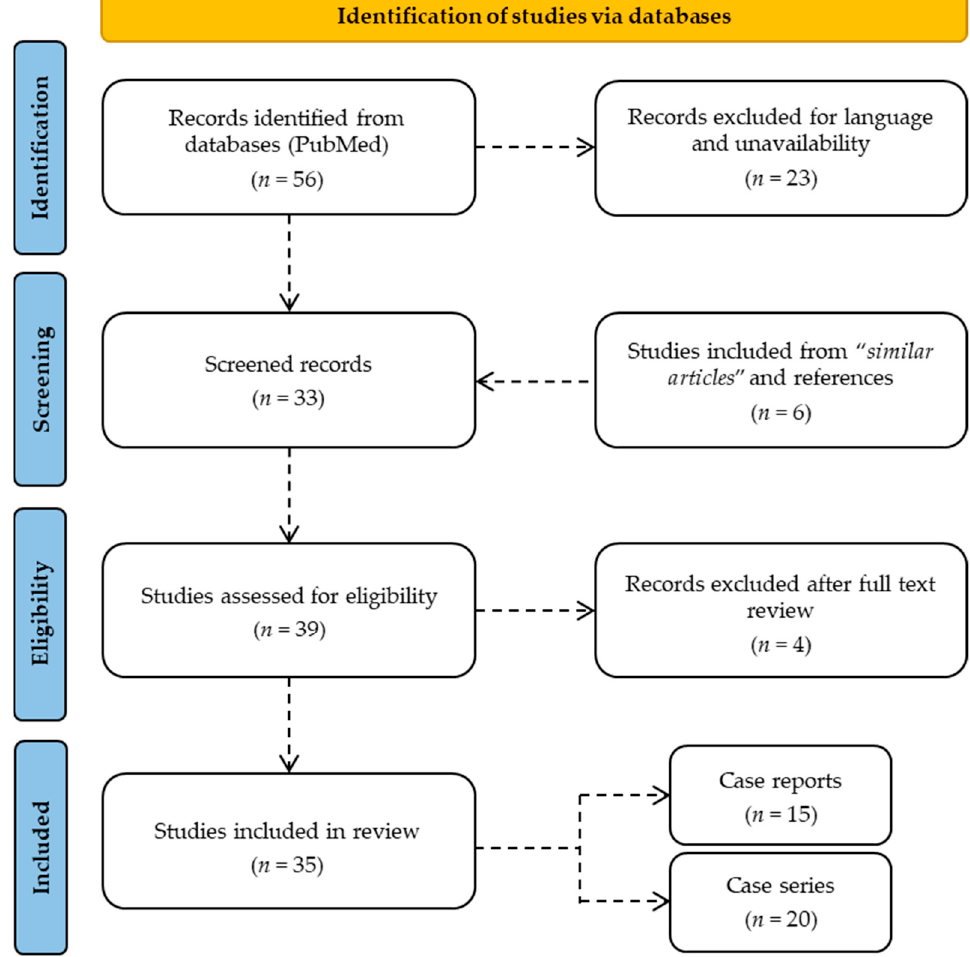
Figure 1. Flow diagram of the design of the study in accordance with the PRISMA 2020